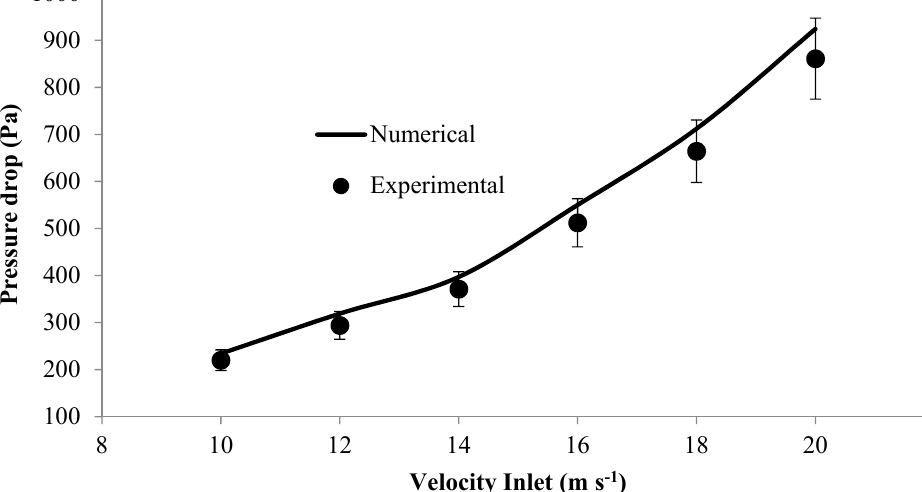
Figure 4. Validation procedure for pressure drop with error bars of 10%.